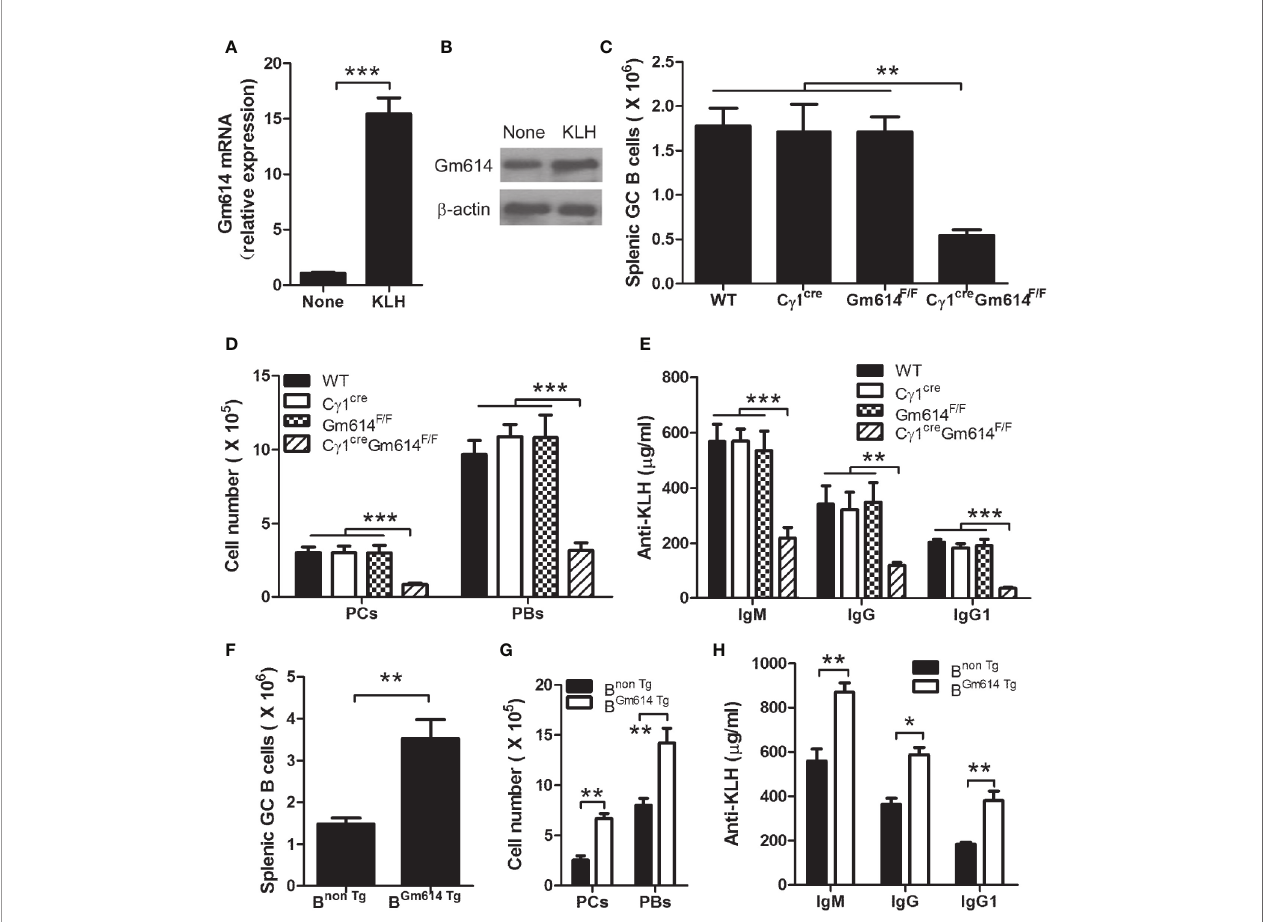
FIGURE 7 | Gm614 up-regulated GC B-cell responses induced by foreign antigen KLH. Nine-week-old WT, C g 1 cre (C g 1-cre), Gm614 F/F (Gm614 fl / fl ), and C g 1 cre Gm614 F/F (Gm614 cKO), or B non Tg and B Gm614 Tg mice were i.p. injected with 100 m g of the protein antigen KLH in a volume of 0.2 mL of saline and analyzed after 28 days. (A, B) Gm614 expression was up-regulated in GC B cells by foreign antigen KLH. GC B cells from splenocytes of six nonimmunized WT mice and KLH-immunized WT mice were sorted by FACS, and subjected to qPCR (A) and western blot (B) analysis. (C – E) Gm614 cKO suppressed GC B-cell responses induced by KLH. Splenocytes and sera were collected from KLH-immunized WT, C g 1 cre , Gm614 F/F , and C g 1 cre Gm614 F/F mice. Splenic CD19 + B220 + CD38 lo GL7 hi GC B cells, CD138 + B220 + PBs, and CD138 - B220 + PCs cells were analyzed and the absolute number of GC B cells (C), and PBs and PCs (D) was shown. Anti- KLH IgM, IgG, and IgG1 were determined in the sera using ELISA assay (E). (F – H) Gm614 Tg promoted GC B-cell responses induced by KLH. Splenocytes and sera were collected from KLH-immunized B non Tg and B Gm614 Tg mice. Splenic CD19 + B220 + CD38 lo GL7 hi GC B cells, CD138 + B220 + PBs, and CD138 - B220 + PCs cells were analyzed and the absolute number of GC B cells (F) , and PBs and PCs (G) was shown. Anti-KLH IgM, IgG, and IgG1 were determined in the sera using ELISA assay (H) . (A – H) Data represent three independent experiments, with six samples per group per experiment. Two-Way (D, E, G, H) and One-Way (C) ANOVA was followed by Bonferroni post-tests and two tailed Student ’ s t-test (A, F) , Error bars, s.e.m., *p < 0.05, **p < 0.01, ***p <